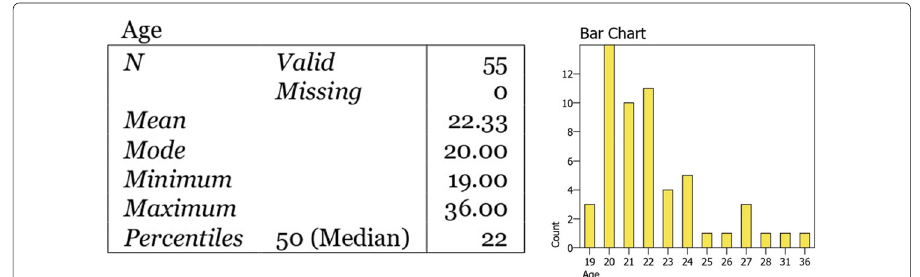
Fig. 7 Distribution of age in the sampled students from morning